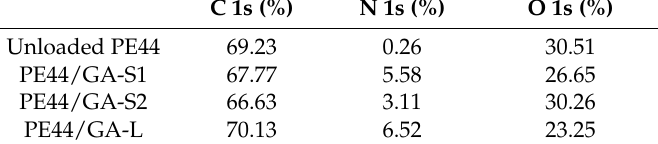
Figure 5. High-resolution XPS spectrum at the C 1s region for unloaded and GA-loaded PE44 fibers. The red line corresponds to the experimental profile while the black lines are the peaks from deconvolution. Unloaded PE44: C–C/C–H (A: 284.8 eV), C–O (B: 286.1 eV) and C=O (C: 288.7 eV). GA-